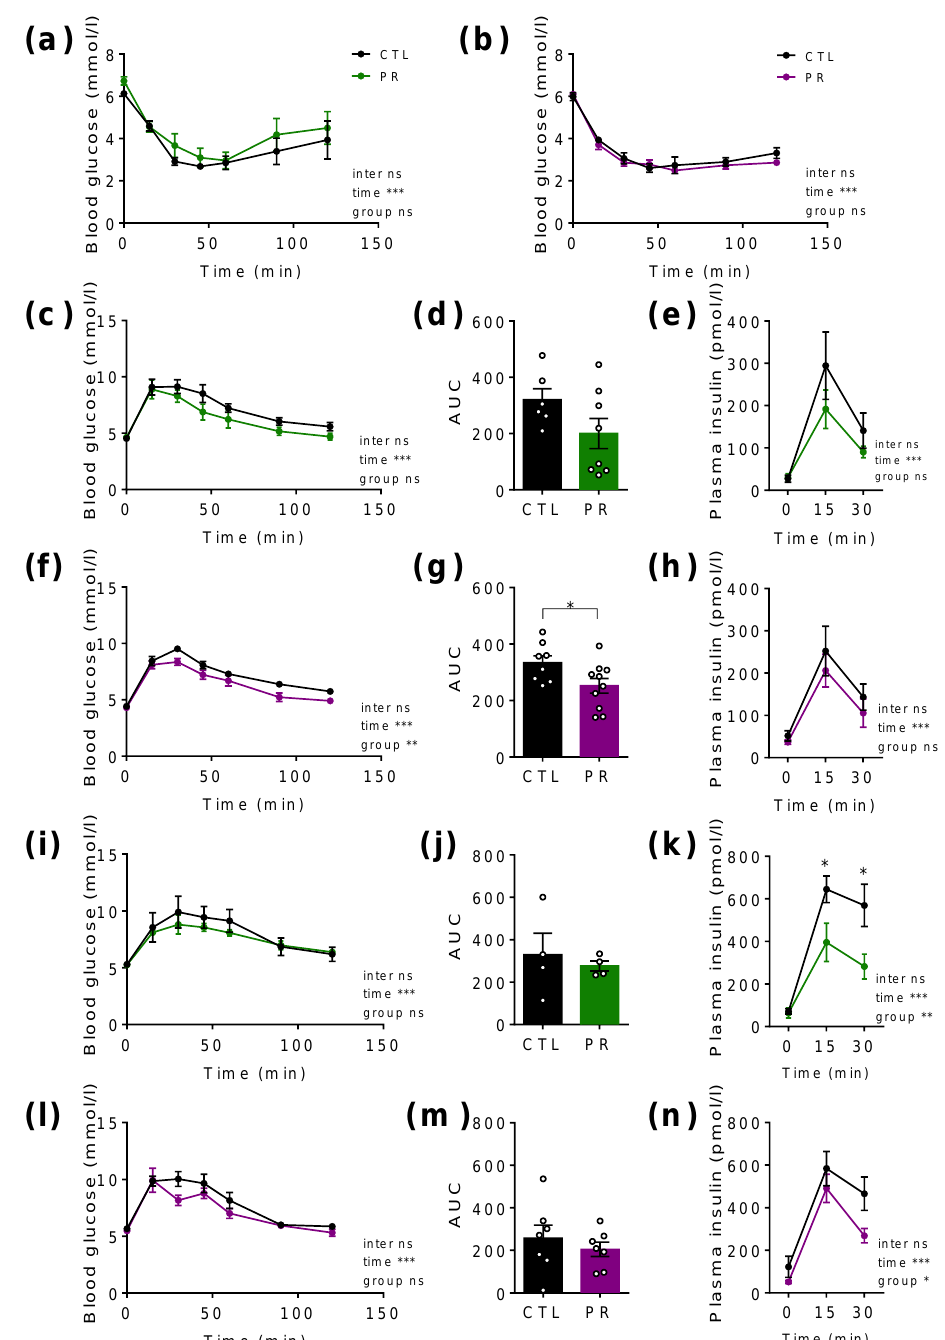
Figure 5. Insulin and glucose tolerance in male and female offspring at postnatal day (PND) 30 and PND100. Blood glucose follow-up after intraperitoneal insulin injection (0.75 U/kg) in male ( a ) and female ( b ) after 5 h-fasting. Blood glucose follow-up after oral glucose gavage (2 g/kg) in male ( c , i ) and female ( f , l ) at PND 30 ( c – h ) and PND100 ( i – n ). Area under the curve (AUC) for male ( d , j ) and female ( g , m ). Plasma insulin in response to blood glucose increase in male (e,k) and female ( h , n ). Black line, CTL; coloured line, PR. Green, male; purple, female. CTL, control. PR, protein restriction; AUC, area under the curve. Data are mean ± SEM or individual values ( n = 5–10). * p < 0.05, ** p < 0.01, *** p < 0.001 vs. CTL, 2-way ANOVA with Sidak post-test, unpaired t